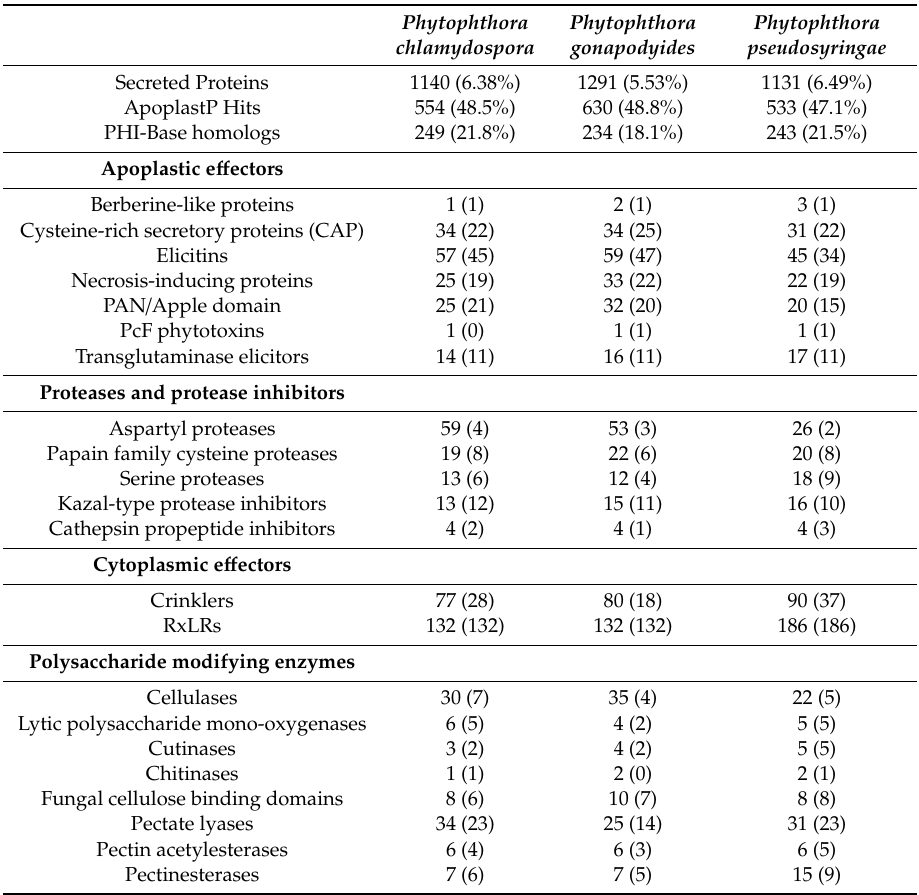
Table 3. Counts of putative e ff ector proteins. Phytophthora